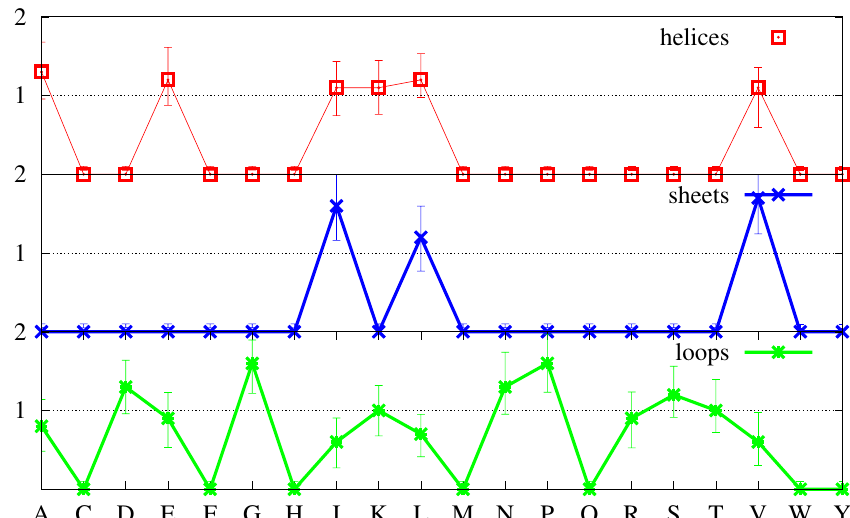
Figure 5. Most probable values for the ratios R ( a , s , p ) (cf. Equation (10)) for α -helices ( top plot , red), β -sheets ( middle plot , blue) and loops ( bottom plot , green). The most probable value is taken from the full distributions for each ratio R ( a , s , p ) and the uncertainty around that value is given by the